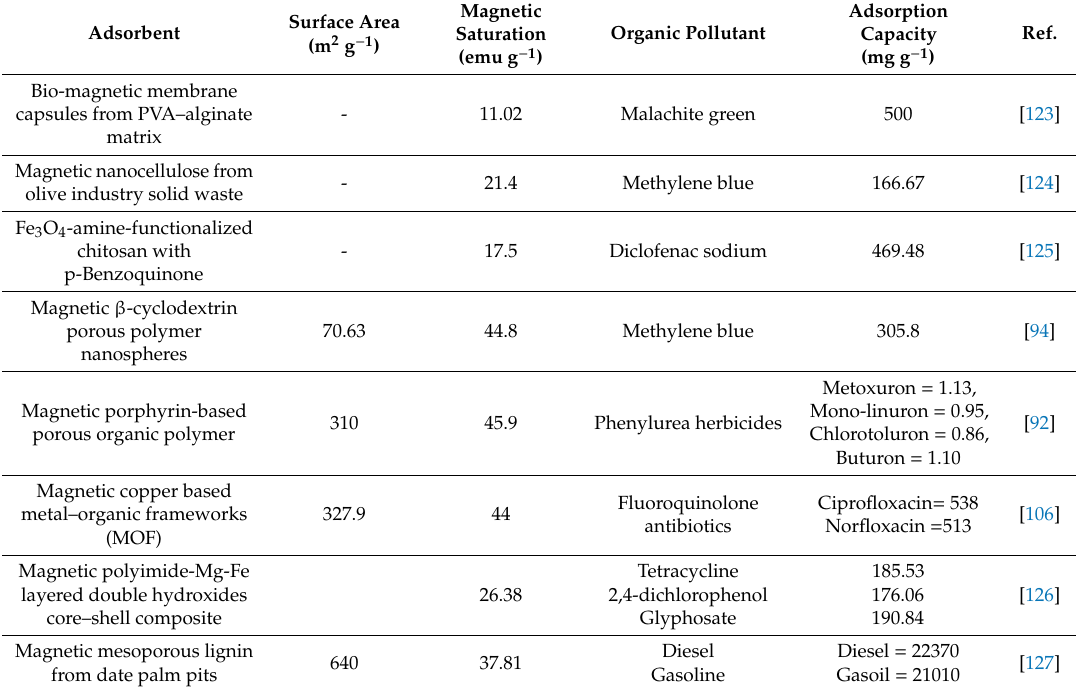
Table 4. Application of magnetic polymer-based nanoadsorbents for organic pollutants removal from